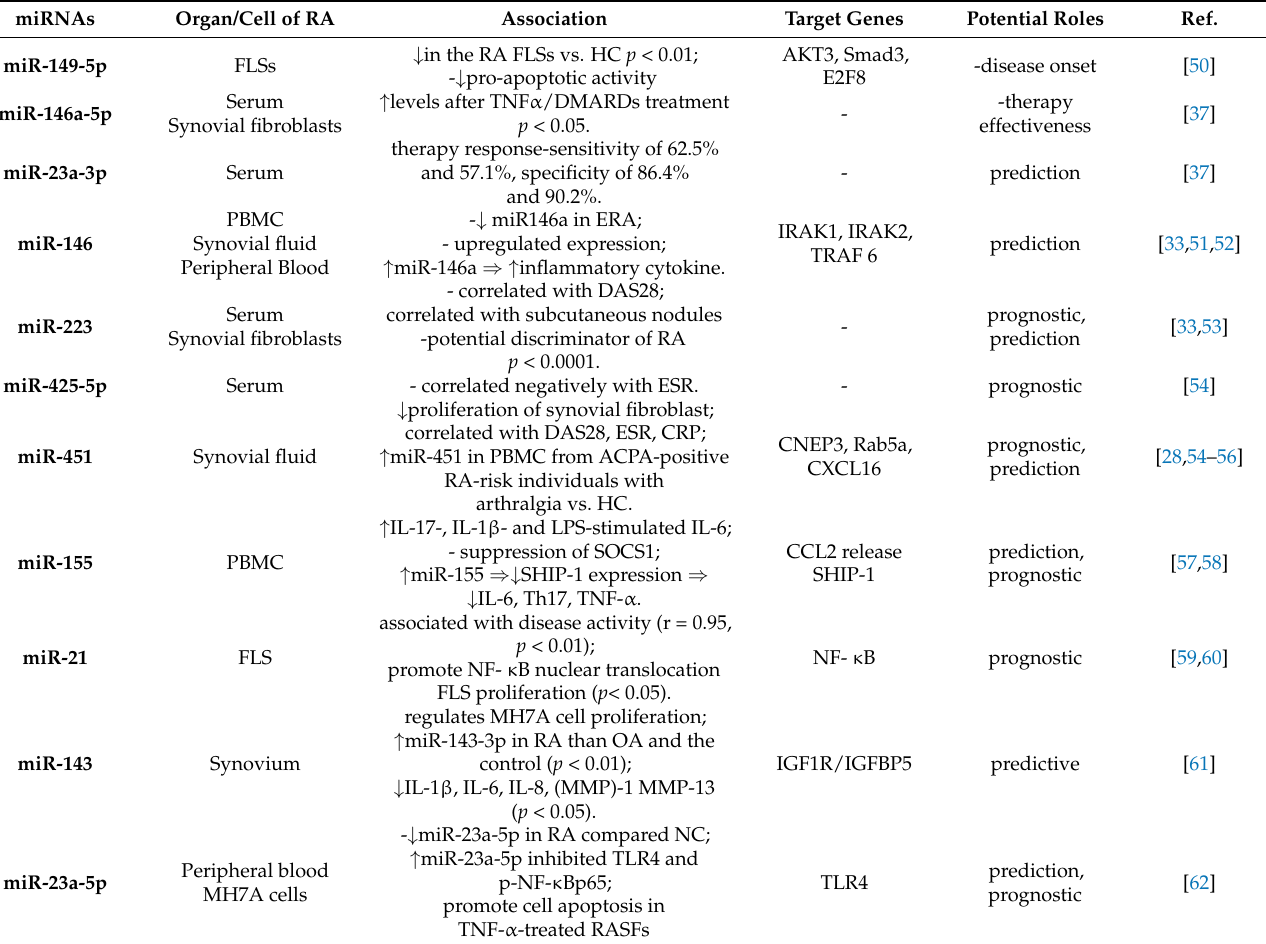
Table 1. miRNAs involvement in RA onset, progression, and disease treatment. Rheumatoid arthritis (RA); fibroblast-like synoviocyte (FLSs); healthy control (HC); Serine/Threonine